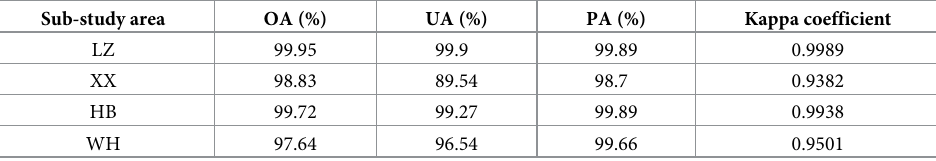
Table 7. Accuracy assessment of cultivated land mapping using the MTVF in the sub-study